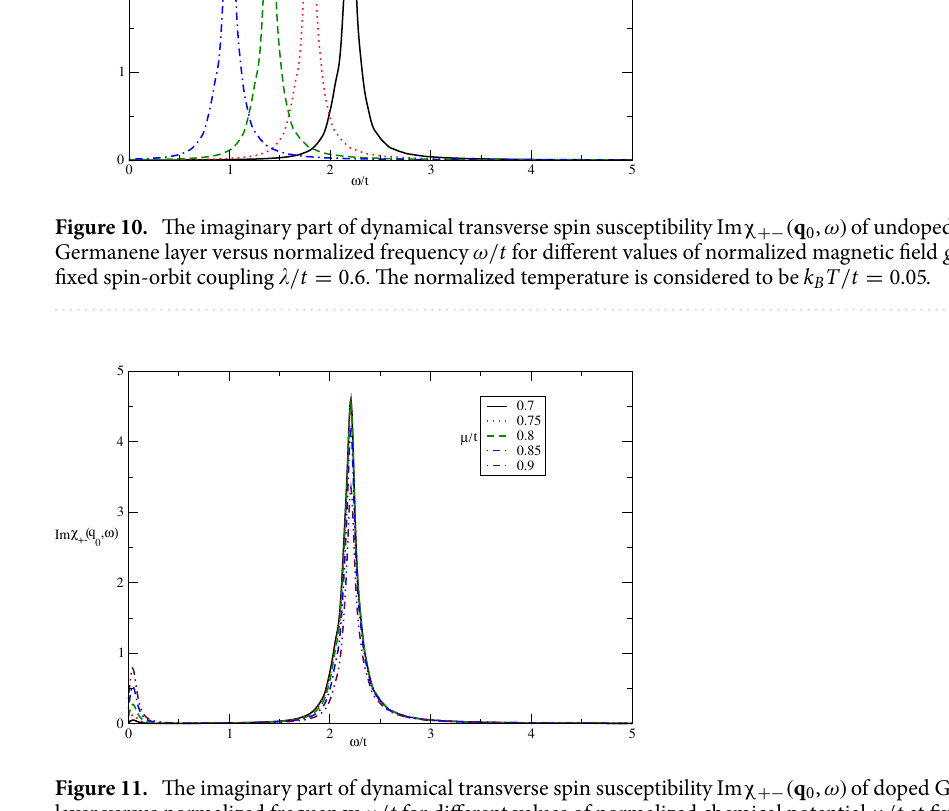
Figure 11. The imaginary part of dynamical transverse spin susceptibility Im χ layer versus normalized frequency ω/ t for different values of normalized chemical potential µ/ t at fixed spin- 0.3 . The magnetic field is assumed to be zero. The normalized temperature is considered to orbit coupling (cid:31) / t = 0.05 be k B T / t =